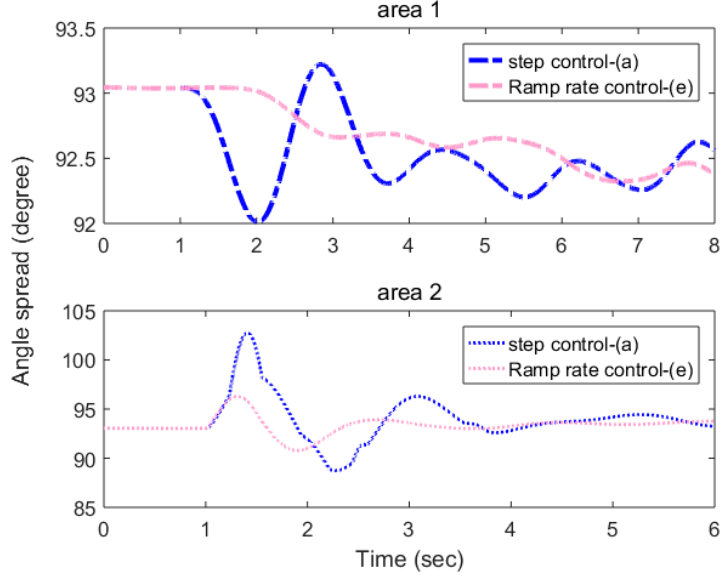
Figure 15. Angle spread results of each area according to (b) and (e).